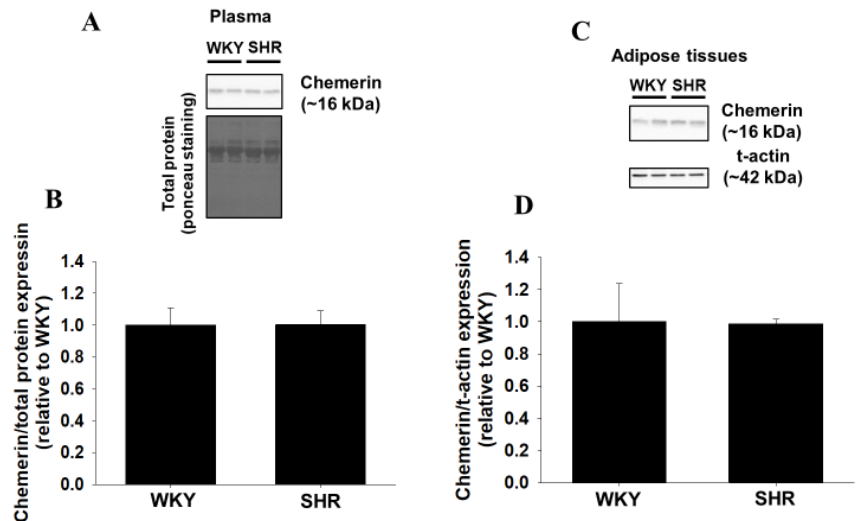
Figure 6. Protein expression of chemerin in plasma and adipose tissues of WKY and SHR. Protein expression of chemerin in heparin-anticoagulated plasma and adipose tissues of WKY and SHR was determined by Western blotting. Representative blots were shown ( A , C ). The normalized chemerin expression relative to total protein ( B ) or total actin (t-actin) ( D ) expression was shown as relative to WKY. Data were shown as mean + SEM in bar graph (( B ): n = 6, ( D ): WKY: n = 3, SHR: n = 4).